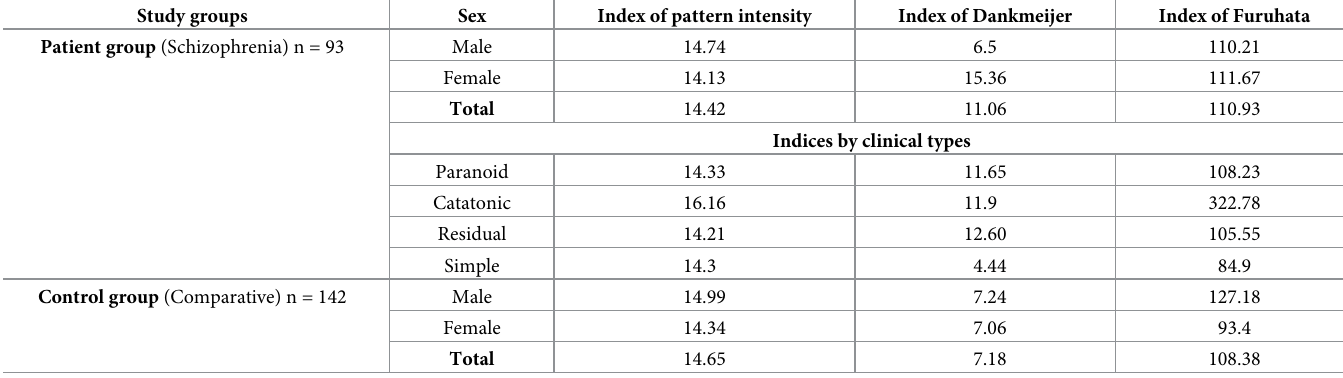
The palmar dermatoglypic patterns were analyzed with evaluating the “atd”, “tda” and “dat” angles to reveal the differences between the schizophrenic patient group and control group. As displayed in Table 9, the mean “atd” angle in schizophrenic patient group and control group produced no statistically significant differences. Table 8. Indices of fingerprint patterns in study groups. Study